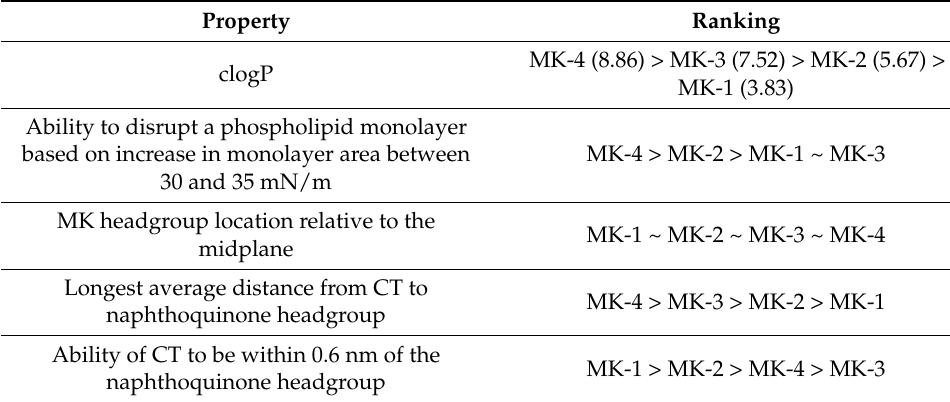
Table 1. Comparing various physicochemical properties of the four MK homologues investigated in this